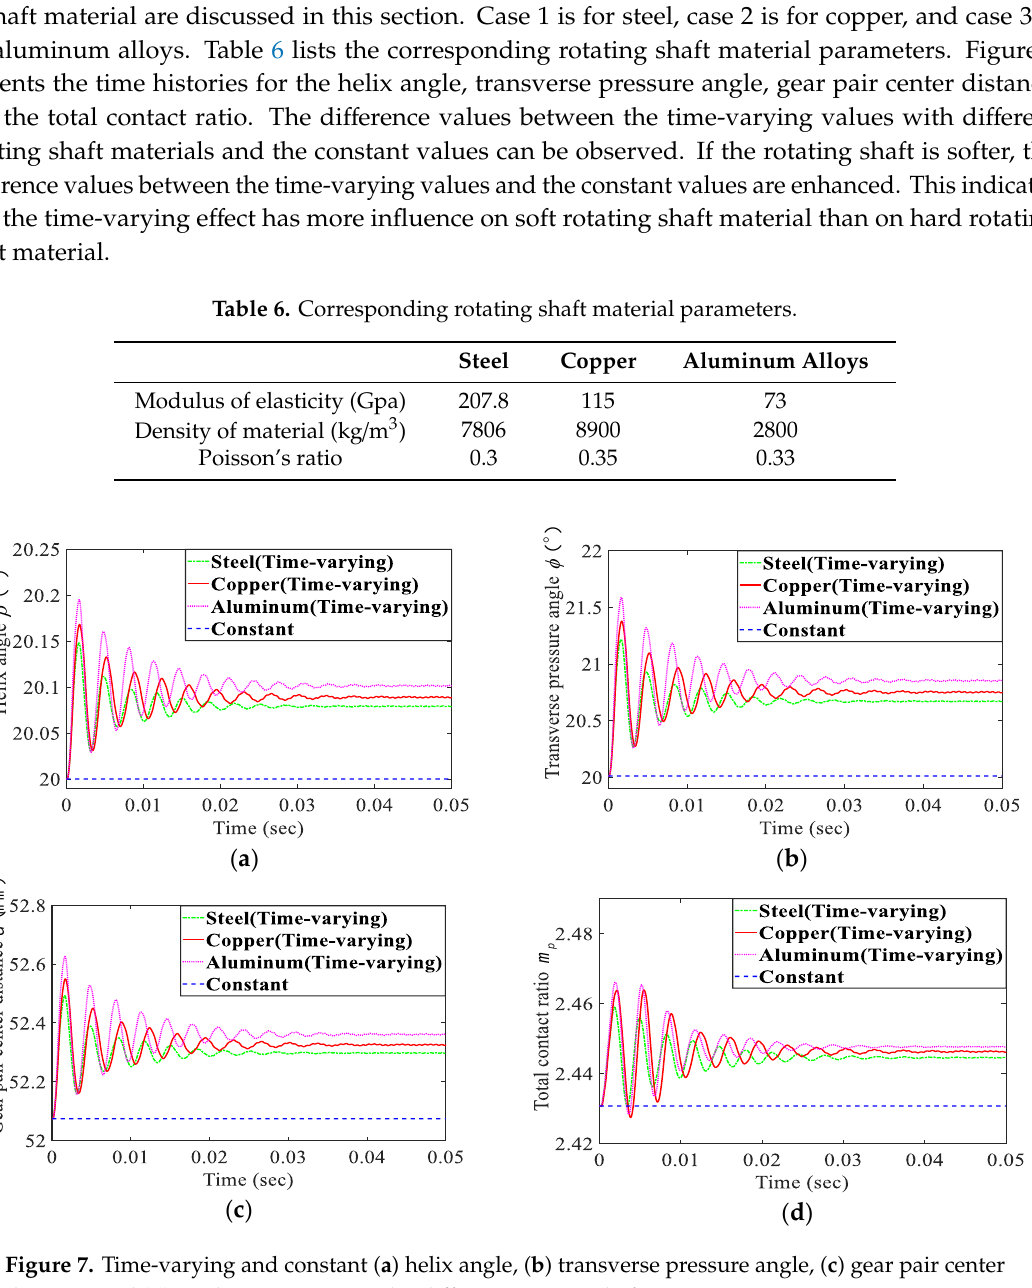
Table 5. The difference values between the time-varying and the constant conditions.